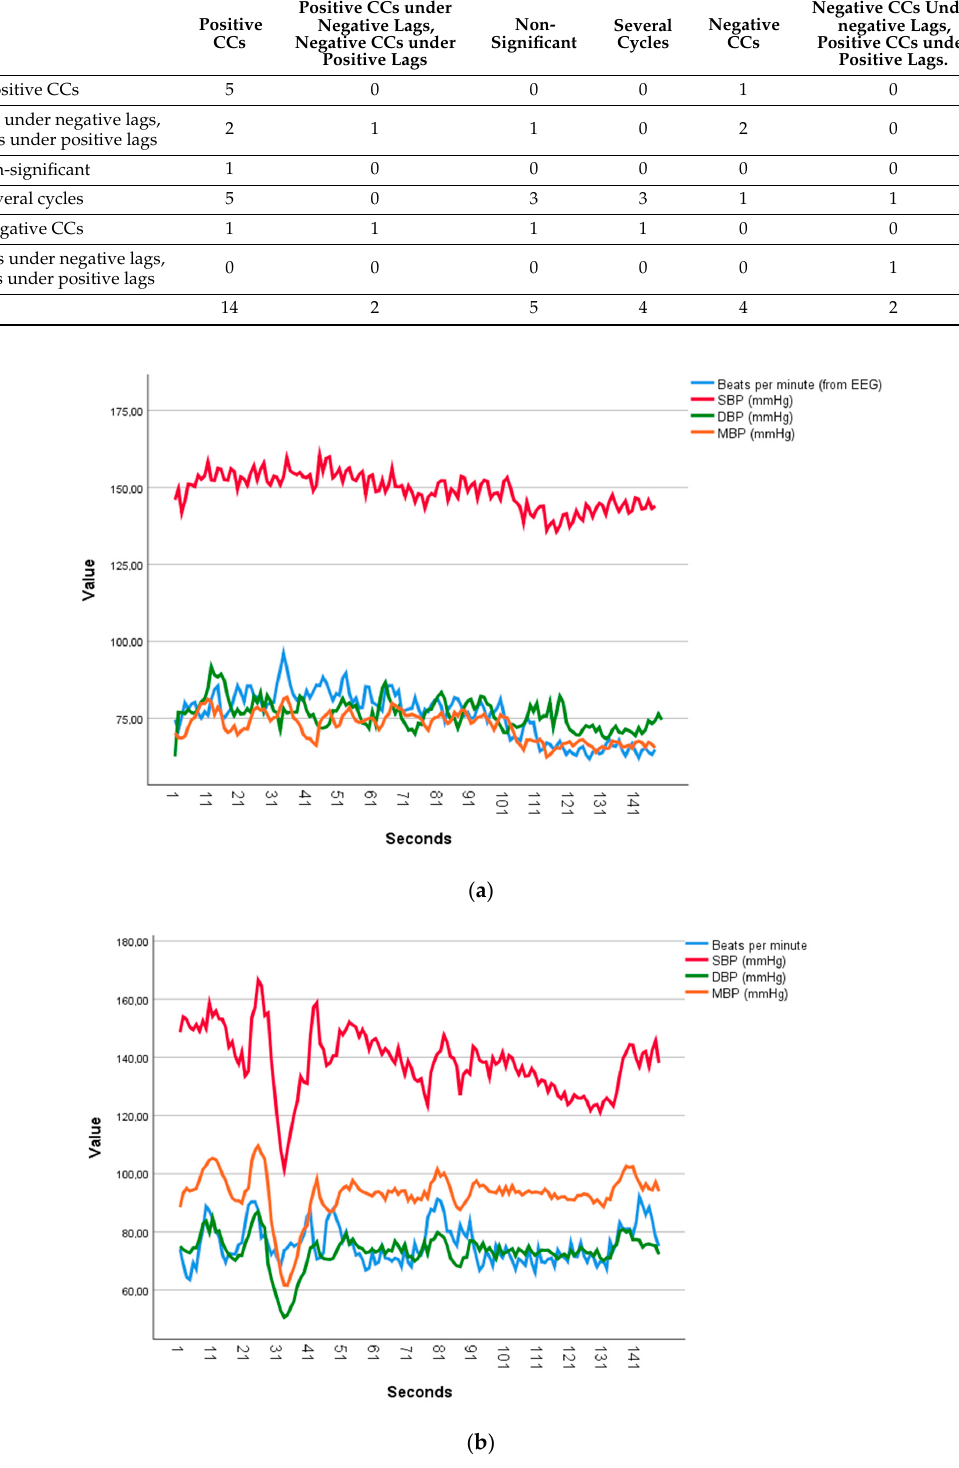
Figure 1. Illustrative case showing the series of HR, SBP, DMB and MBP (in seconds) during ( a ) Math task and ( b ) Rumination task on the same individual of a most frequent type of heart rate– blood pressure cross-correlations (CCs) profile: Cases with significant positive CCs during math task and several cycles of CCs during rumination (95% confidence interval).